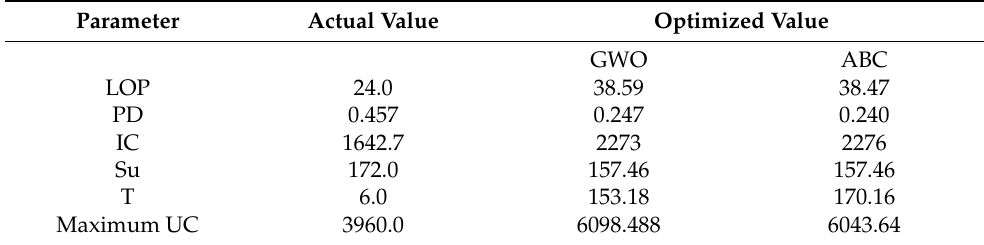
Table 2. Optimized values of input parameters for the maximum UC.